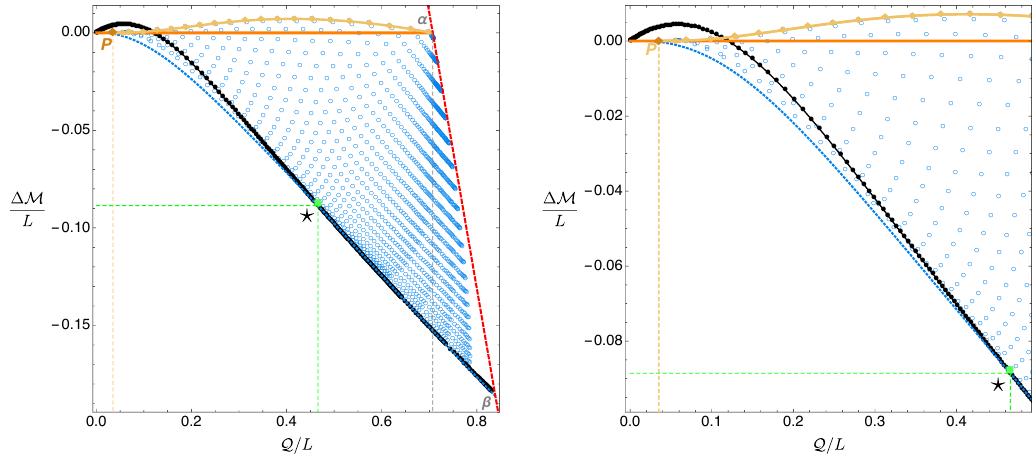
) in Figure 7 . Phase diagram for Einstein theory with a scalar field charge e = 2 ( e c ≤ e < e S a Minkowski box. As before, the blue circles describe hairy black holes, the black disk curve is the soliton main family, and the orange line is the extremal RN BH (RN black holes exist above it). The gray and red dashed curves have the same interpretation as in figure 4. The green solid square labelled with a star ( ? ) has ( Q ∆ M ) ∼ (0 . 466 , 0 . 659 , − 0 . 0886) . The auxiliary blue ? , M ? , ? dotted curve P ? β in the bottom describes the line where hairy BHs terminate with unbounded horizon curvature. Hairy BHs that terminate in the trench P? of this auxiliary curve have zero temperature ( T = 0 ) and finite entropy S/L = πR 2 . On the other hand, hairy BHs that terminate + in the trench segment ?β (that coincides with the black soliton line) have zero entropy and large (possibly infinite) temperature. Note that these ?β terminal hairy BHs have the same ( Q , ∆ M ) as the main soliton family with Q > Q ?